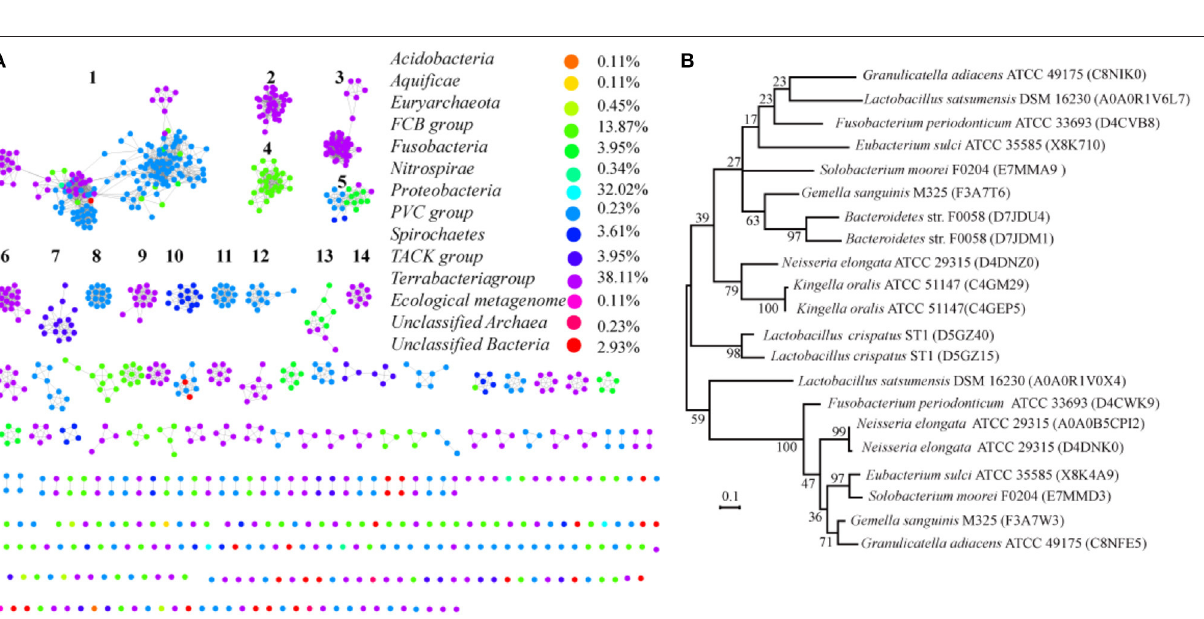
Frontiers in Plant Science | www.frontiersin.org